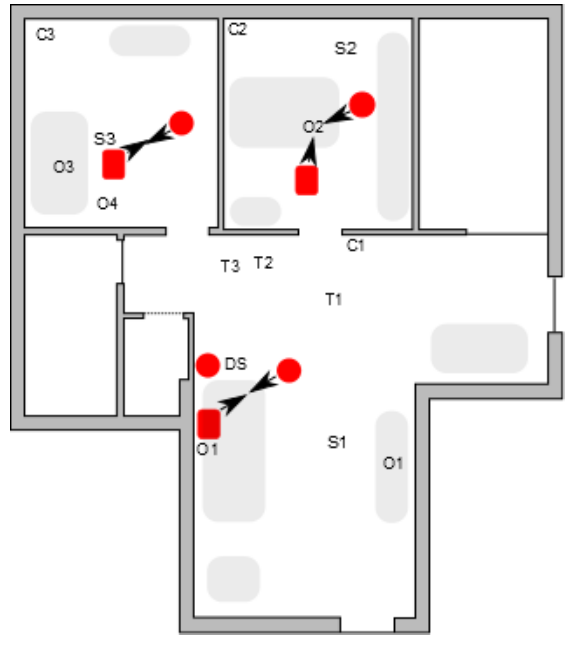
Figure 4. A graphical overview of the scripted scenario used in the experiment. C1-C3 are locations of cameras. S1-S3 are situations. T1-T3 are spatial transitions. DS is the docking station. The researcher (R) is denoted by a vertical rectangle and the participant (P), that is embod- ied in Giraff, is denoted by a circle. The arrows denote how R and P were expected to be spatially oriented in the situations